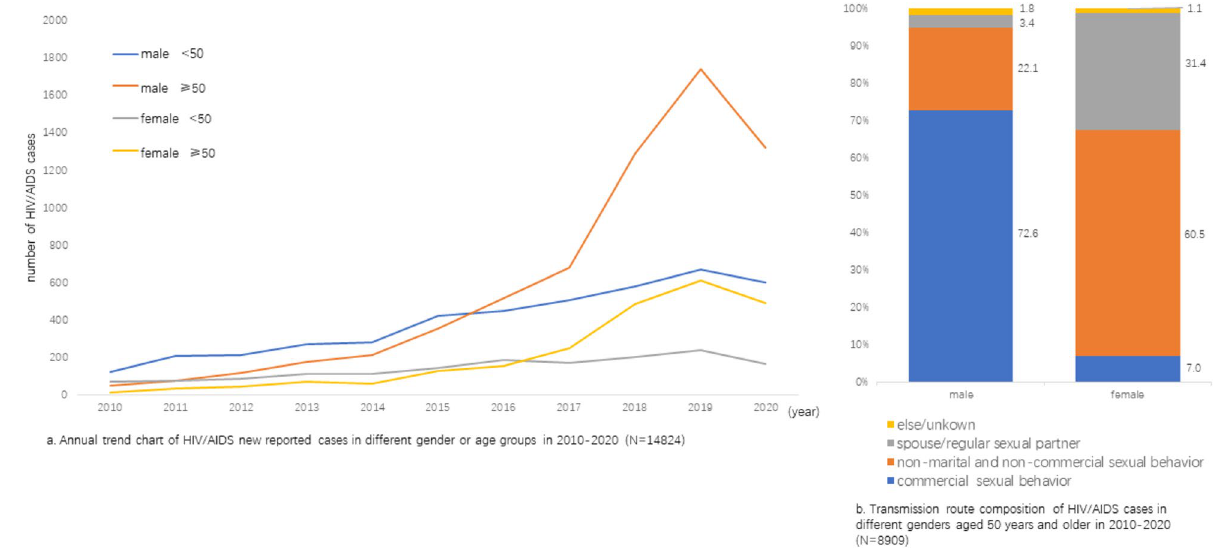
Figure 1. Growth trend of newly reported HIV/AIDs cases and transmission route among cases aged 50 years and older in 2010–2020.